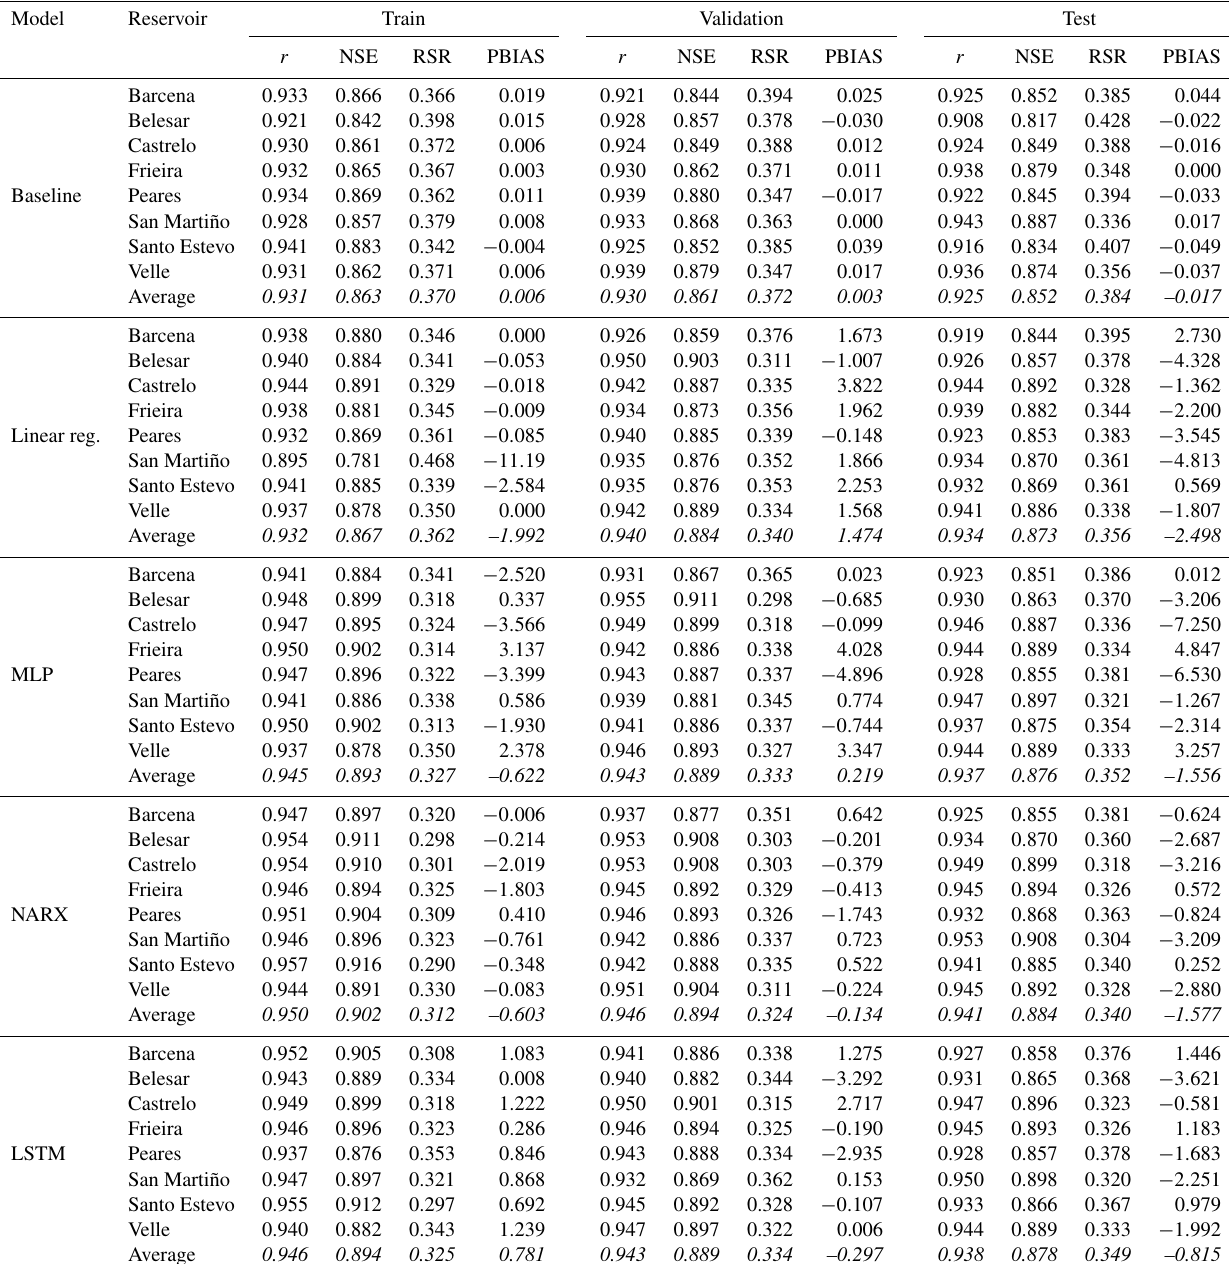
Table 3. Statistical performance of the different models developed to predict the outflow. Averages are given in italics.